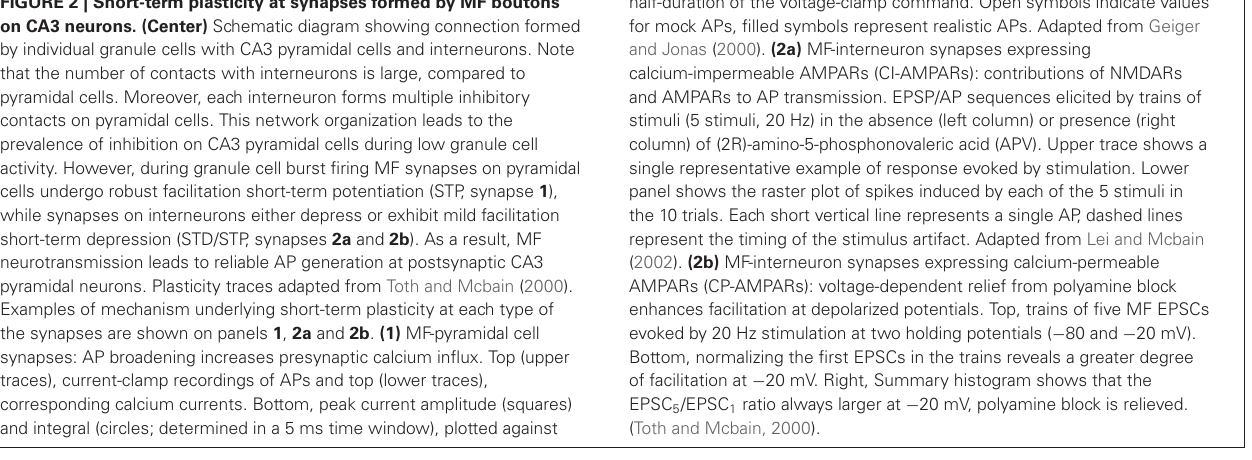
FIGURE 2 | Short-term plasticity at synapses formed by MF boutons on CA3 neurons. (Center) Schematic diagram showing connection formed by individual granule cells with CA3 pyramidal cells and interneurons. Note that the number of contacts with interneurons is large, compared to pyramidal cells. Moreover, each interneuron forms multiple inhibitory contacts on pyramidal cells. This network organization leads to the prevalence of inhibition on CA3 pyramidal cells during low granule cell activity. However, during granule cell burst firing MF synapses on pyramidal cells undergo robust facilitation short-term potentiation (STP, synapse 1 ), while synapses on interneurons either depress or exhibit mild facilitation short-term depression (STD/STP, synapses 2a and 2b ). As a result, MF neurotransmission leads to reliable AP generation at postsynaptic CA3 pyramidal neurons. Plasticity traces adapted from Toth and Mcbain (2000). Examples of mechanism underlying short-term plasticity at each type of the synapses are shown on panels 1 , 2a and 2b . (1) MF-pyramidal cell synapses: AP broadening increases presynaptic calcium influx. Top (upper traces), current-clamp recordings of APs and top (lower traces), corresponding calcium currents. Bottom, peak current amplitude (squares) and integral (circles; determined in a 5 ms time window), plotted against